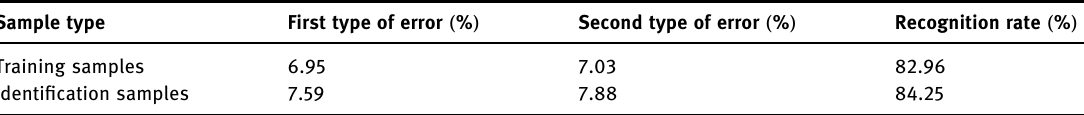
Table 3: Identi fi cation results based on FCM clustering algorithm Sample type